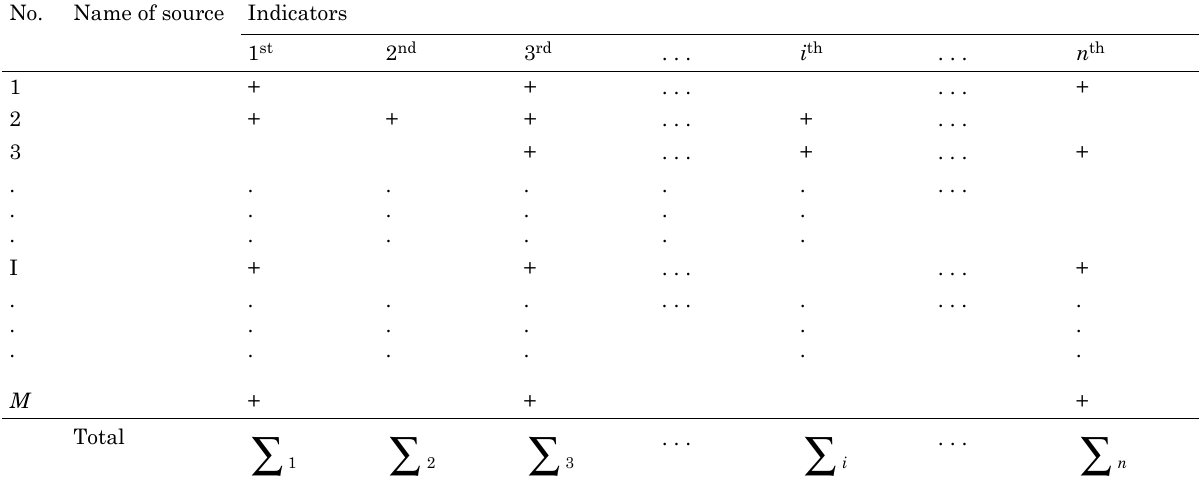
table 1. Initial table for the formation of the system of indicators for the analyzed phenomenon no. name of source